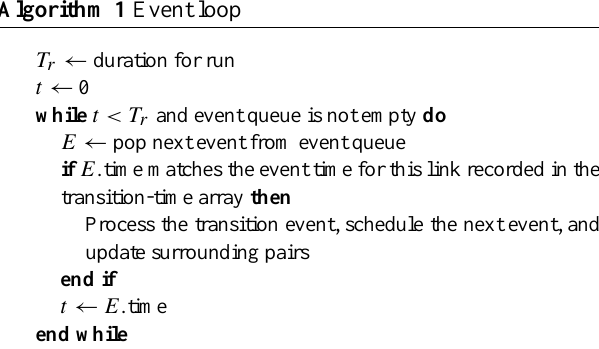
Algorithm 1 Event loop